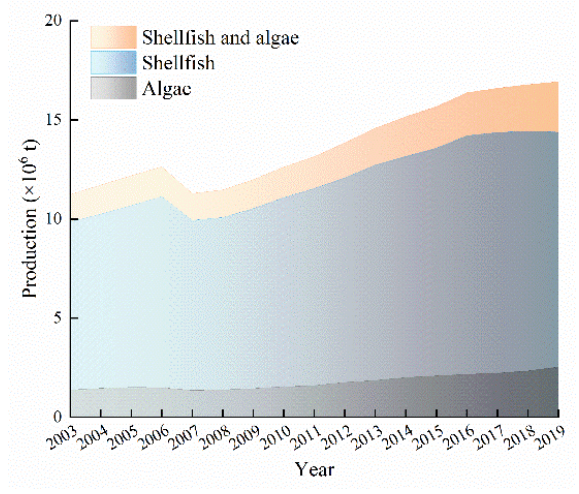
Figure 2. Cumulative output of shellfish and algae mariculture in China from 2003 to 2019. Shellfish mariculture made up the majority of the total output of shellfish and algae mariculture, with an annual average proportion of 87.35%. From 2003 to 2019, the cumula- tive output of shellfish mariculture in China exceeded 200 million tons, with an average annual output of 12.03 million tons. Crassostrea gigas , Ruditapes philippinarum , and Chlamys farreri were the main species of marine shellfish culture in China (Figure 3a) and together amounted to 80.81% of the total shellfish output.